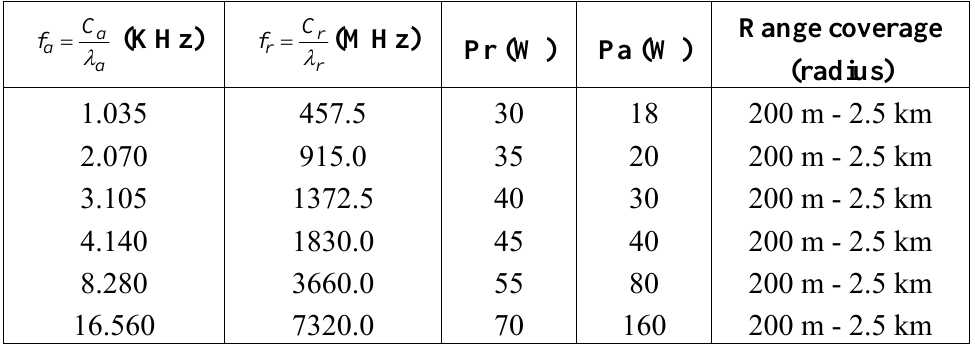
Table 1. Possible frequencies and power level of acoustic sources and Radar.